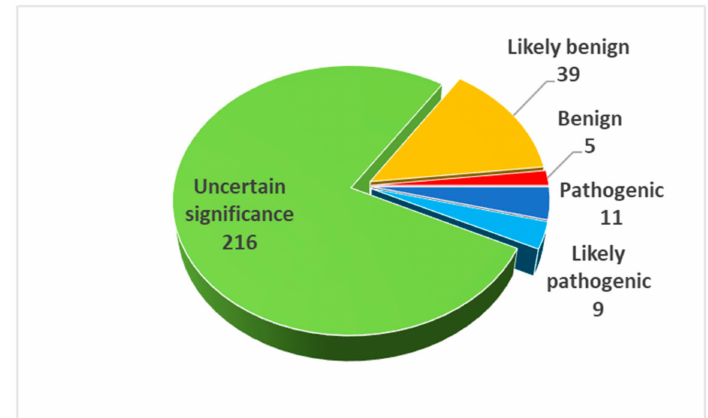
Figure 2. Pie chart of identified sequence variants distributed by ACMG classification, with standard InterVar interpretation of the PP2 and BS1